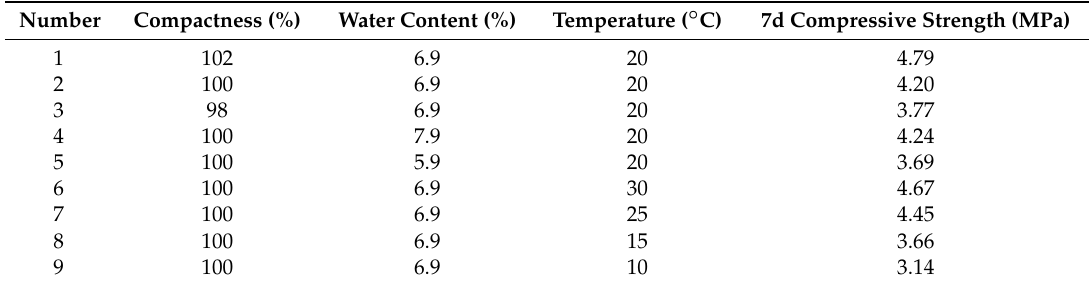
Table 1. Raw data for reference and contrast